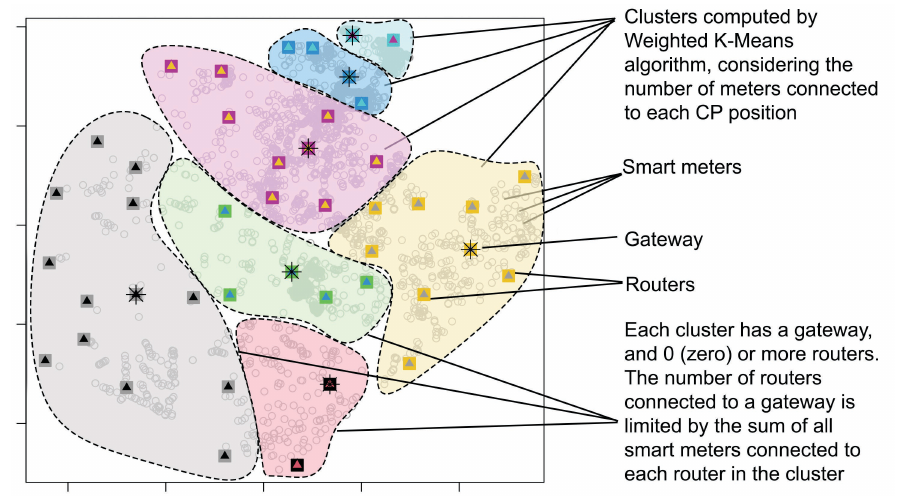
Figure 6. Gateway positioning. The figure presents the different clusters computed by the Weighted K-Means algorithm. Each group has a gateway positioned and can have zero or more